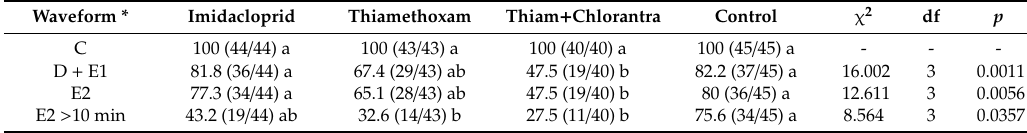
Table 1. Percentage of Diaphorina citri that produced a specific waveform type (PPW) on Citrus sinensis nursery trees treated by drench with systemics insecticides, during 8-h time